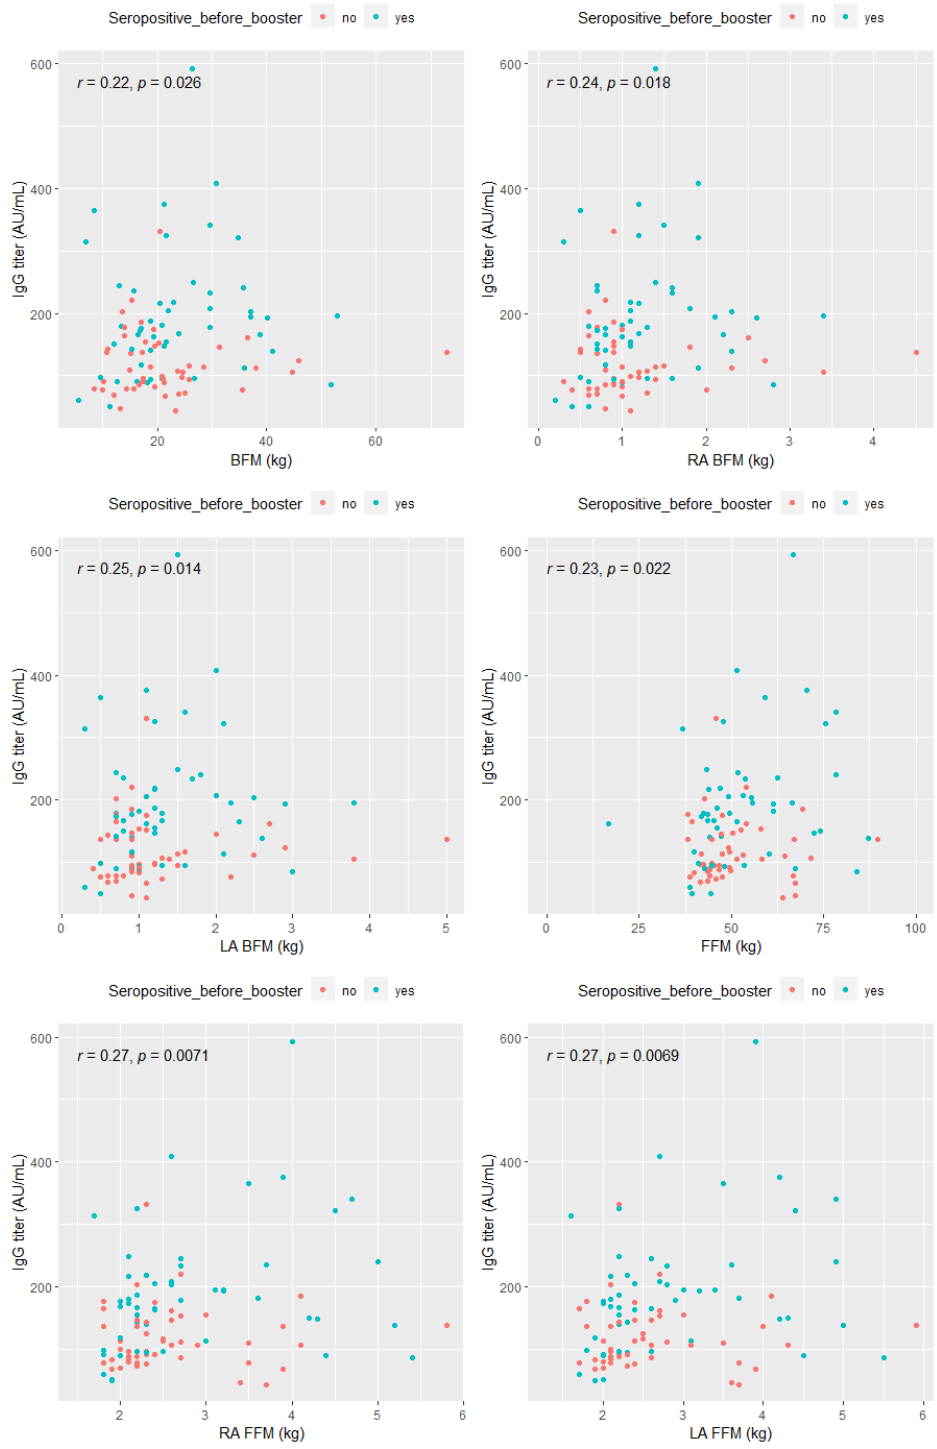
Figure 5. Spearman correlation between anti-SARS-CoV-2 IgG titers and selected parameters